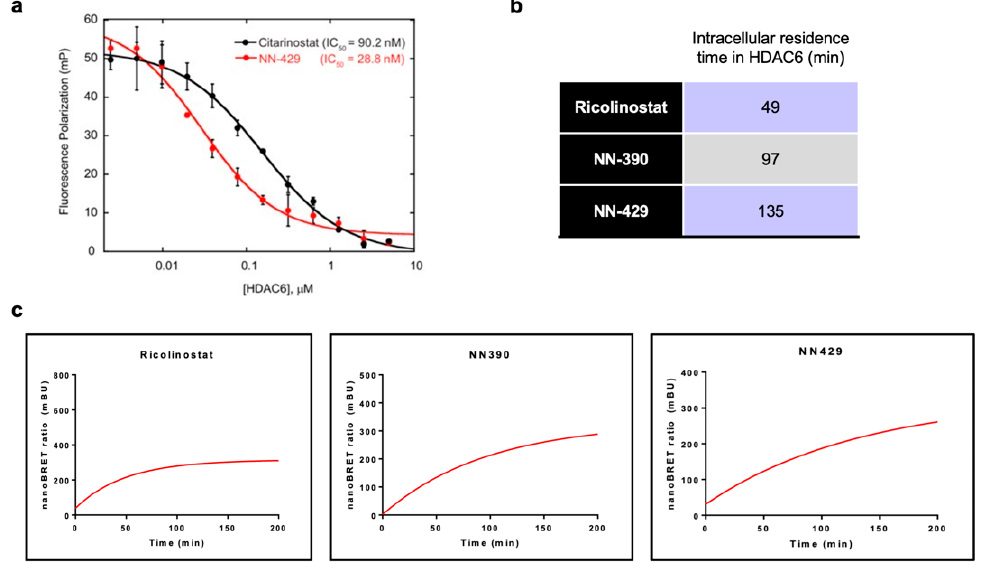
Figure 5. ( a ). Dose–response curves of NN-429 and citarinostat against recombinant zf HDAC6 using fluorescence polarization. Fluorescence polarization IC 50 data against zf HDAC6 is provided. ( b ). In cellulo residence time of selected compounds for HDAC6 target engagement in HeLa cells transiently expressing HDAC6-NanoLuc full-length fusion protein. ( c ). Residence time analysis of ricolinostat, NN-390 and NN-429 in HDAC6 within live cells.